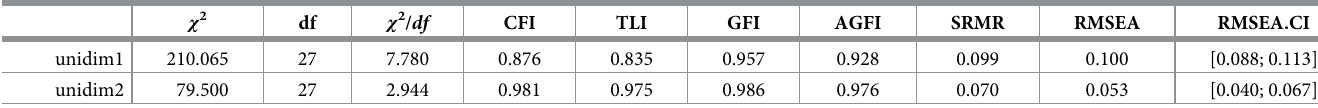
Table 6. Fit indexes of tested models in the validation of DFS-BR.